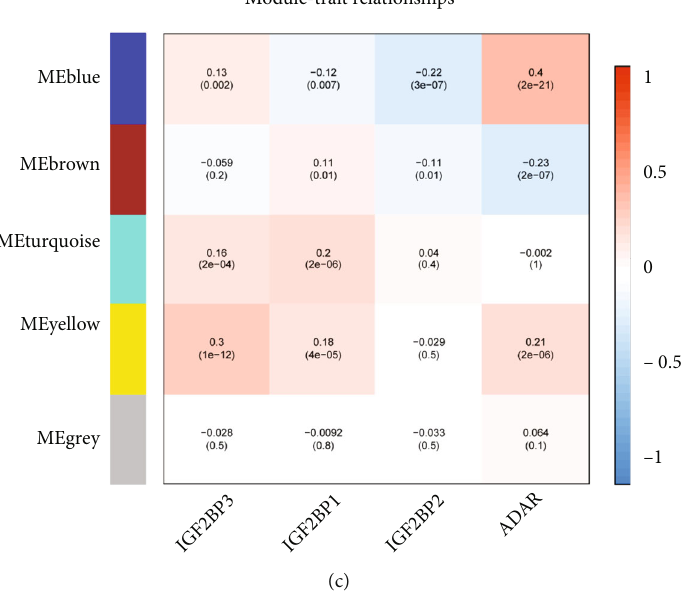
Figure 3: Identi fi cation of the prognosis-related AS events that are associated with the expression of RNA-modi fi ed genes. (a) Expression of RNA-modi fi ed genes in cancer and normal tissues. (b) Hierarchical clustering tree of the RMA-AS events in TCGA-HNSCC. (c) Hierarchical clustering tree of the RMA-AS events in TCGA-HNSCC. (d) Association of the AS events with RNA modi fi ed